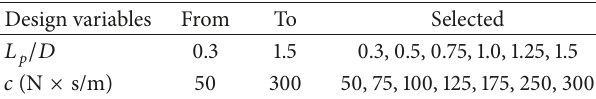
Table 5: Design variables and their range of